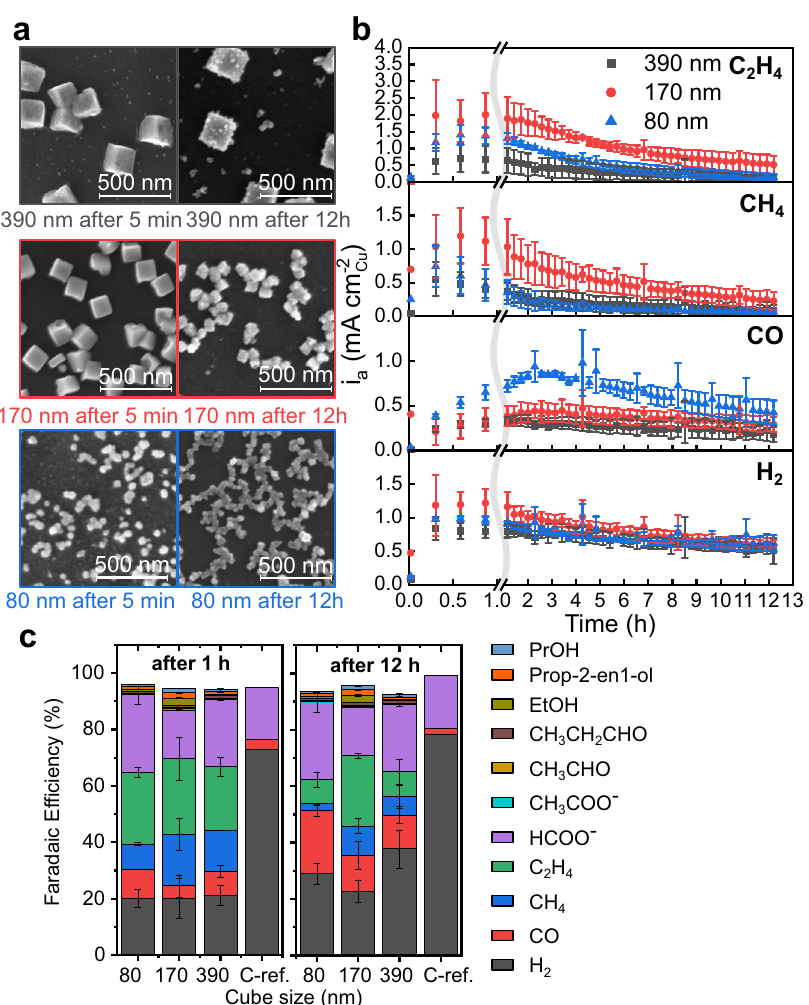
Fig. 3 Product analysis from CO 2 RR over Cu 2 O cubes deposited on glassy carbon. a SEM images of Cu cubes with three different average size distributions measured ex situ after 5 min and 12 h of CO 2 RR. b Partial current densities for H 2 , CO, CH 4 , and C 2 H 4 obtained from time-resolved gas chromatography data acquired over 12 h. The currents are normalized by the exposed surface area of the as-synthesized Cu 2 O cubes. Note that this normalization does not consider the dynamic morphological changes observed under reaction conditions. Faradaic ef fi ciencies of all measured reaction products after c 1 h and 12 h of CO 2 RR at − 1.1 V RHE . The ef fi ciency in c is slightly lower than 100% due to evaporation of liquid products and